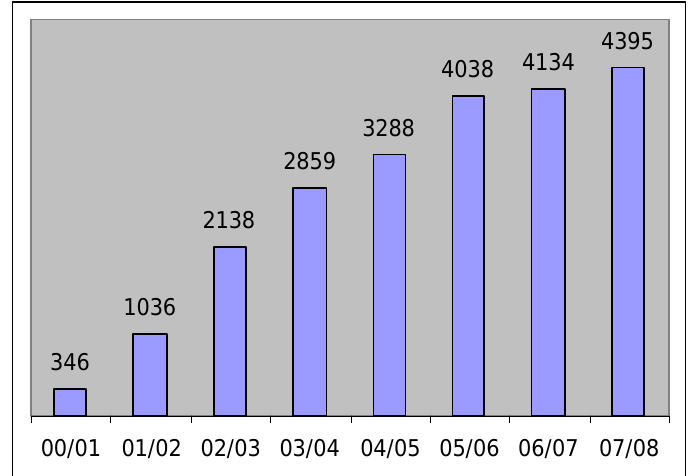
Figure 1. Number of courses using Virtual TAU in the academic years 2000-01 –